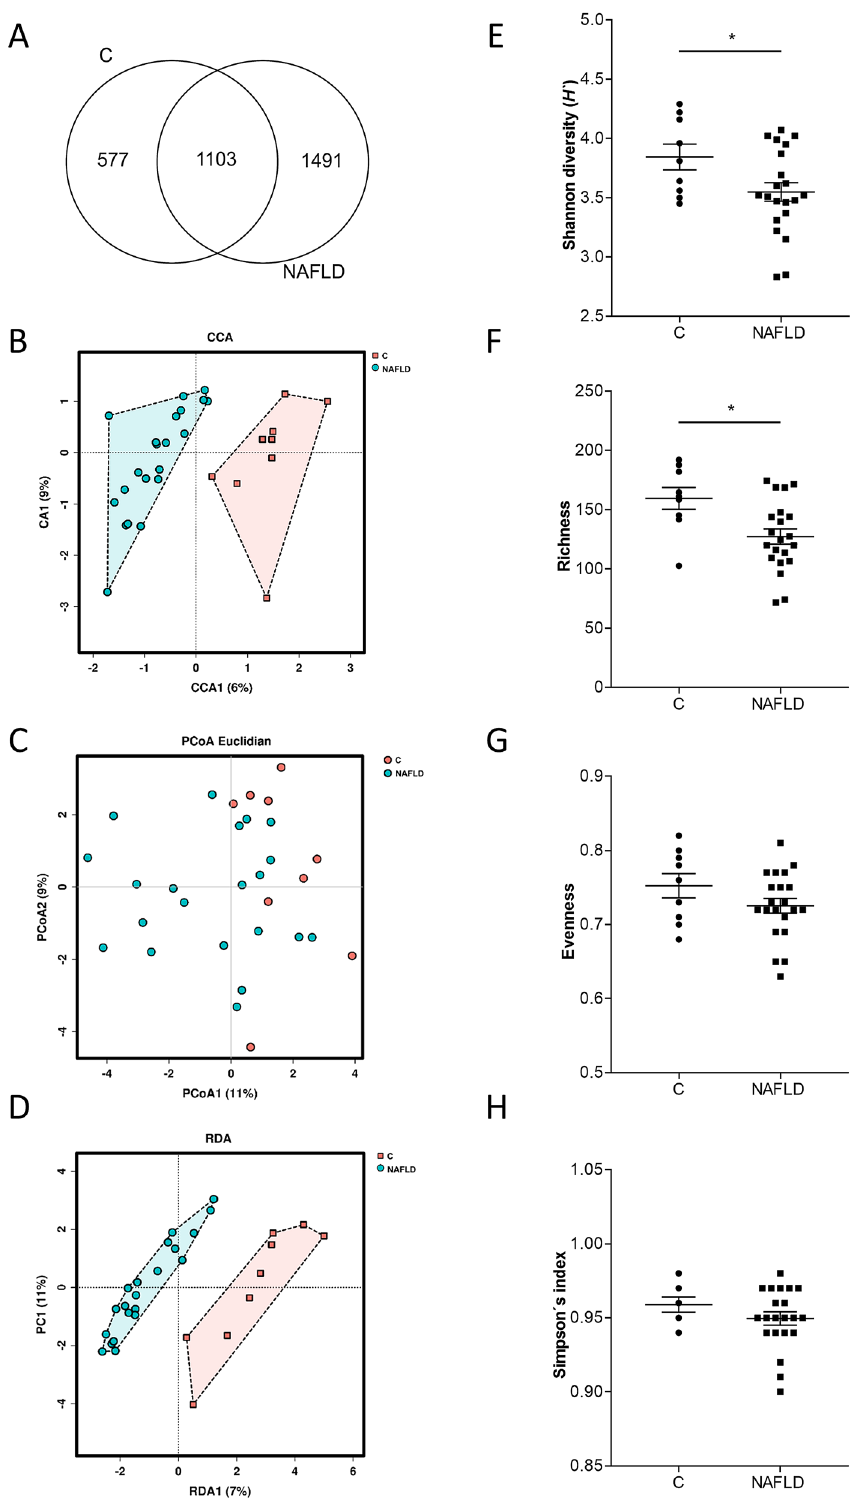
Figure 1. Global bacterial community structure and diversity indexes of intestinal microbiota in NAFLD patients and controls. ( A ) Venn diagram representing the operational taxonomic units (OTUs)/species of the unfiltered reads, ( B ) Principal Coordinates Analysis (PCoA) with Elucidian dissimilarity distance, ( C ) canonical correspondance analysis (CCA) and ( D ) redundance analysis (RDA), ( E ) Shannon diversity index, ( F ) species richness, ( G ) species evenness and ( H ) Simpon’s index. Each dot represents the microbial community of each proband. Data are shown as means ± SEM, n = 9 controls, n = 21 NAFLD patients, * p ≤ 0.05. C healthy controls, NAFLD patients with non-alcoholic fatty liver